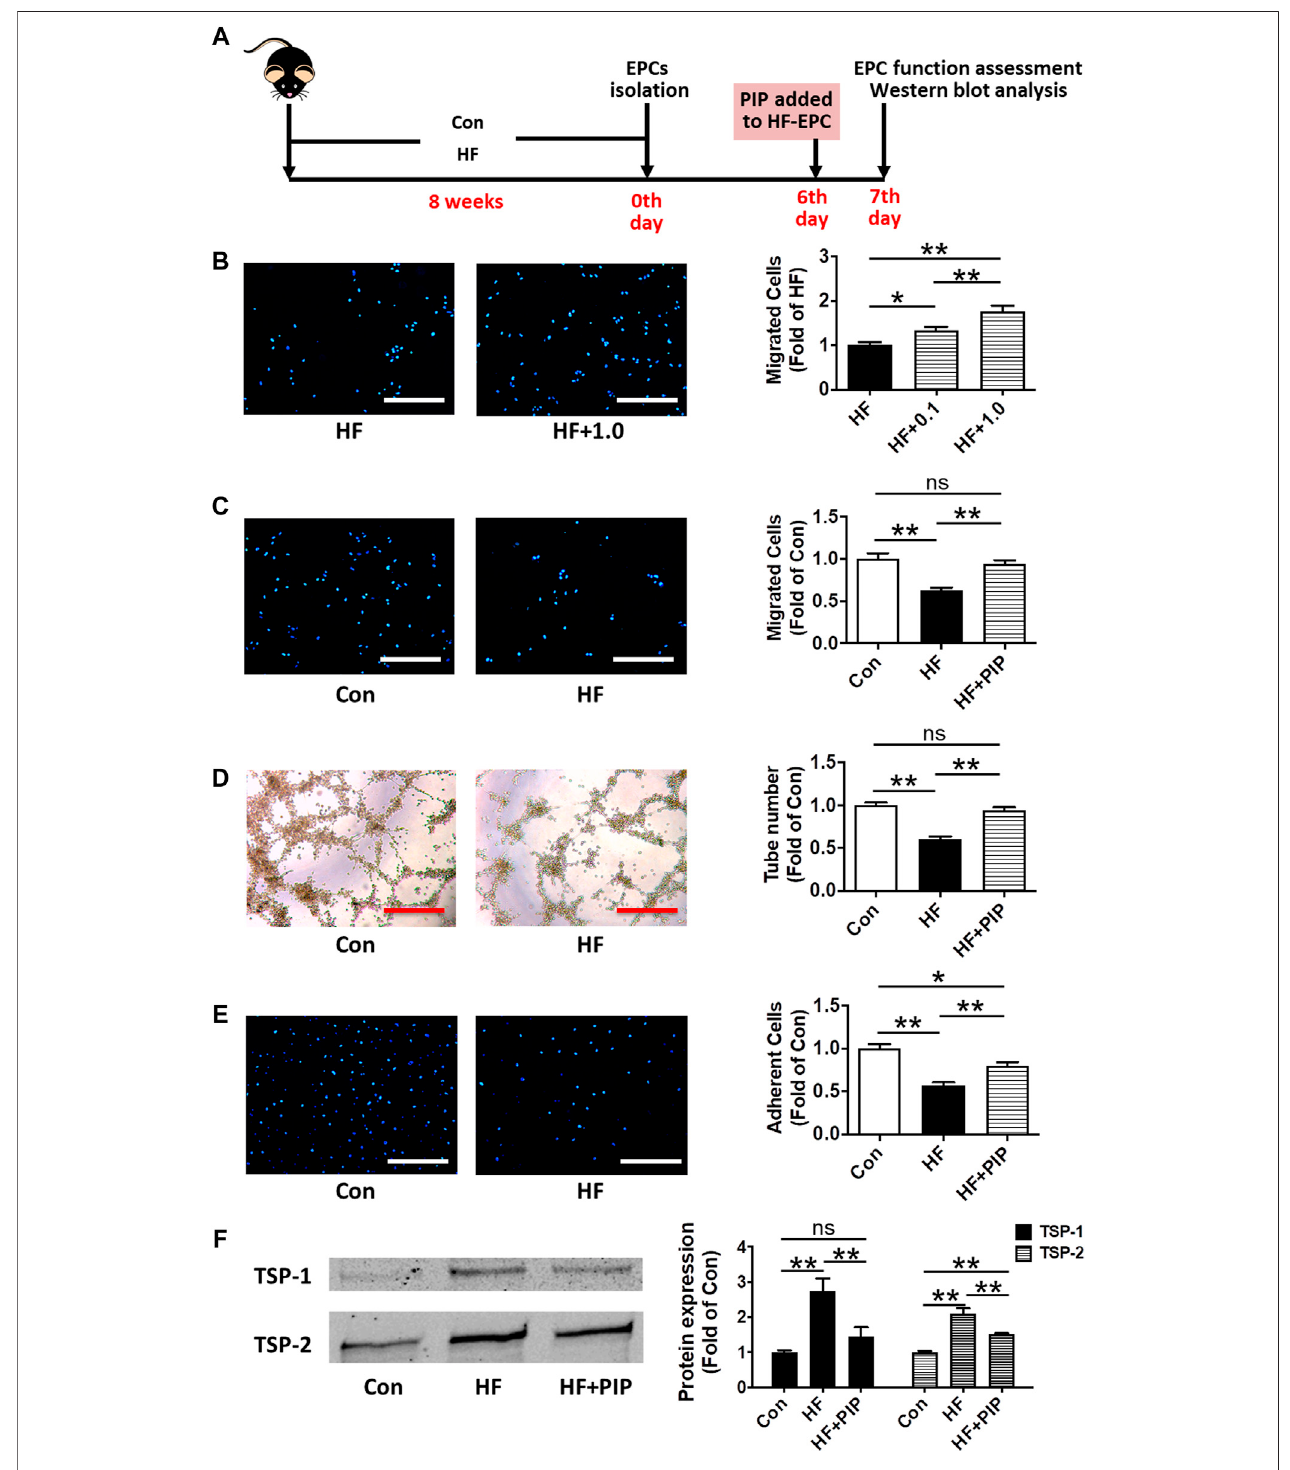
FIGURE 4 | Incubation with piperlongumine rescued the impaired functions of EPCs from HFD-fed mice. (A) , Surgical protocols: Male C57BL/6 mice (8 weeks) were fed with high-fat rodent chow for 8 weeks. Then, the EPCs were isolated from the HFD-fed mice. After 6 days, piperlongumine was added to EPCs. Then, EPC functions were measurement at the 7 th day. (B) , Effects of piperlongumine (0.1 and 1.0µM, 24 h) on migration function of EPCs from HFD-fed mice (n (cid:2) 15 per group). (C) , EPC migration assay (n (cid:2) 13 per group). (D) , Tube formation assay of EPCs (n (cid:2) 15 – 20). (E) , Adhesion assay of EPCs (n (cid:2) 17 – 20). (F) , the representative images and the protein expression levels of TSP-1 (n (cid:2) 7) and TSP-2 (n (cid:2) 6). Throughout, bars represent means; error bars represent SEM. Values were normalized to Con or HF. * p < 0.05, ** p < 0.01. Con, control EPC; HF, EPC from HFD-fed mice; HF+0.1, piperlongumine (0.1µM, 24 h)-incubated EPC from HFD-fed mice; HF+1.0, piperlongumine (1.0µM, 24 h)-incubated EPC from HFD-fed mice . HF + PIP, piperlongumine (1.0µM, 24 h)-incubated EPC from HFD-fed mice. Scale bar: 200 μ m.